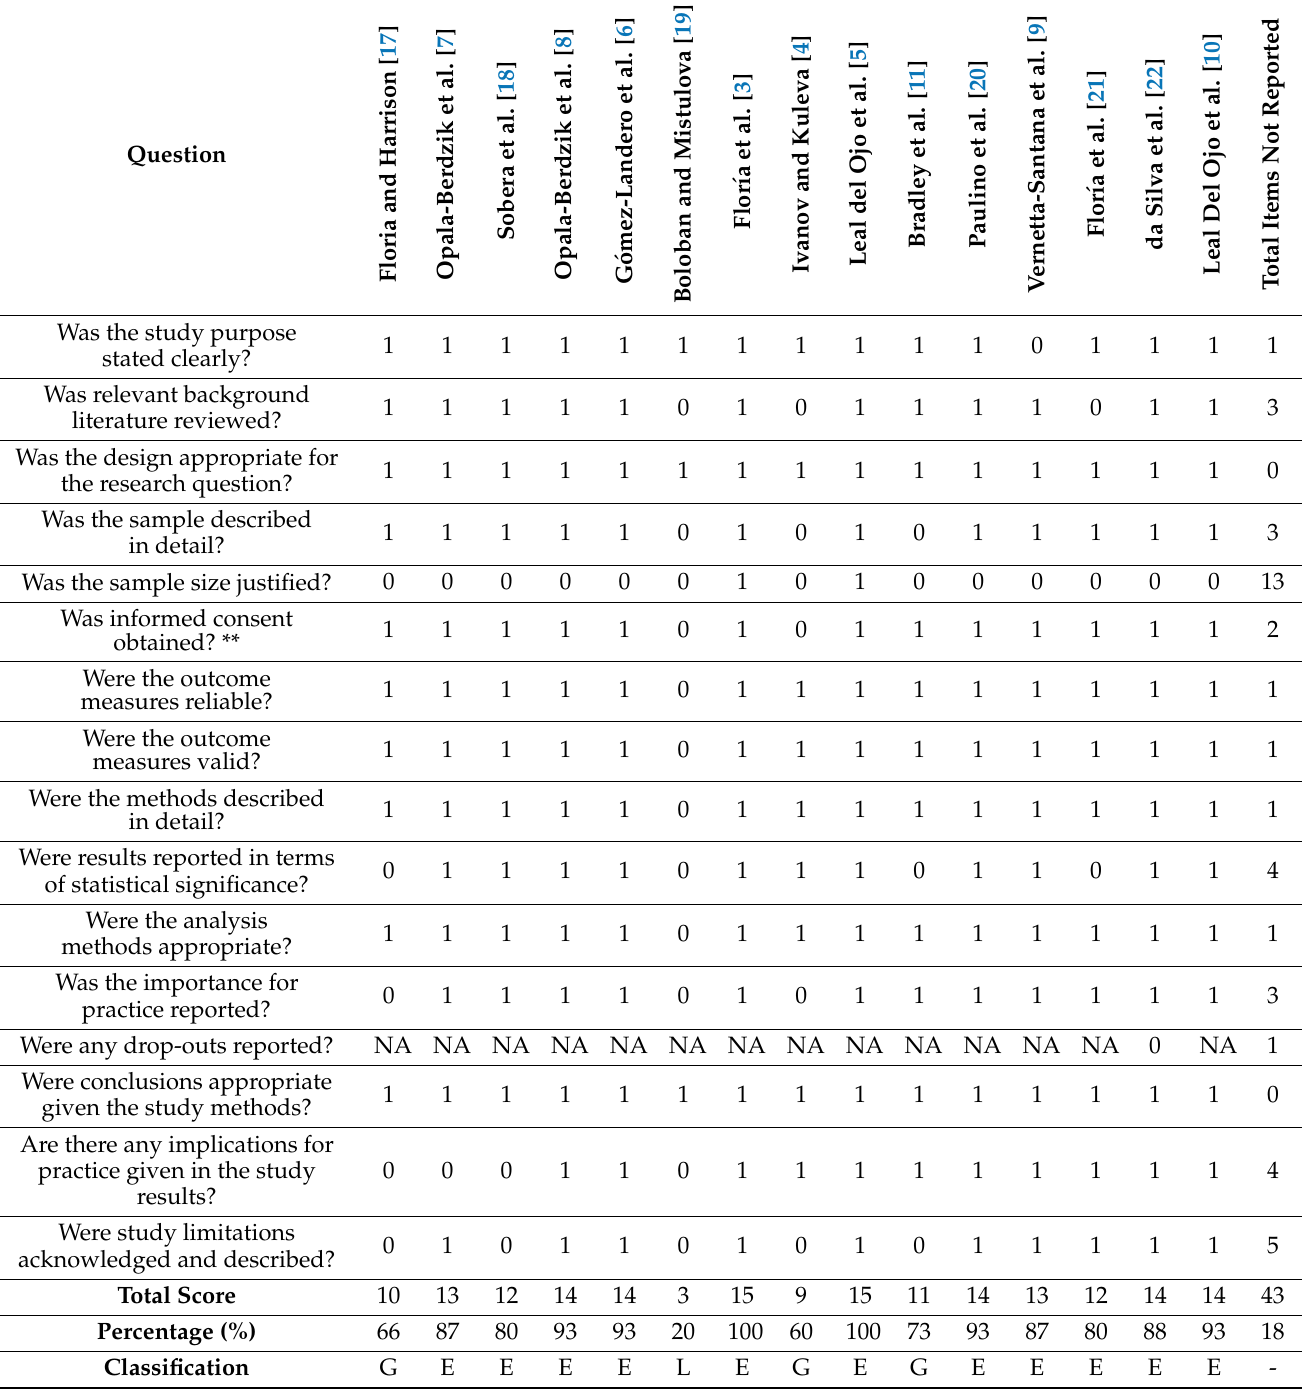
Table 1. Results from the quality control assessment of the documents included in the review ( n =